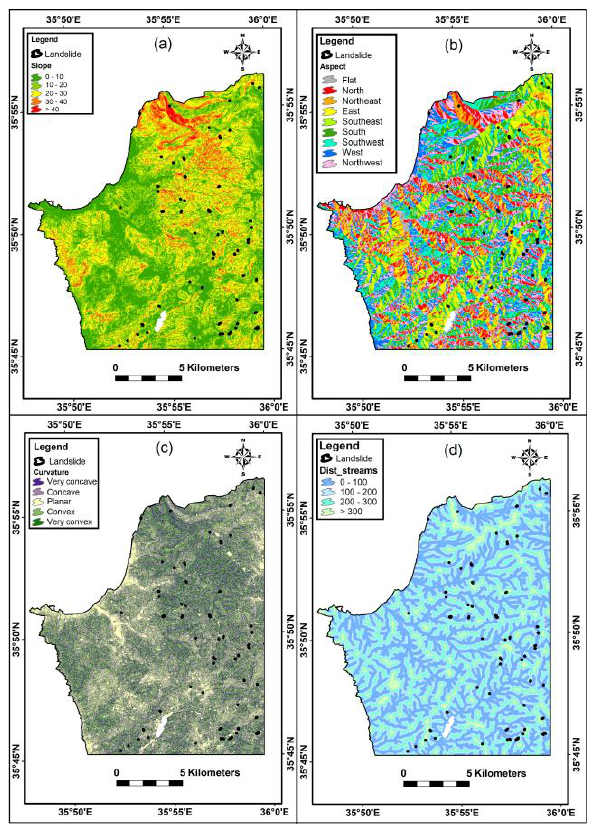
Figure 8. The causative factors maps extracted from the DEM. a- Slop. b- Aspect. c- Curvature. d- Distance from